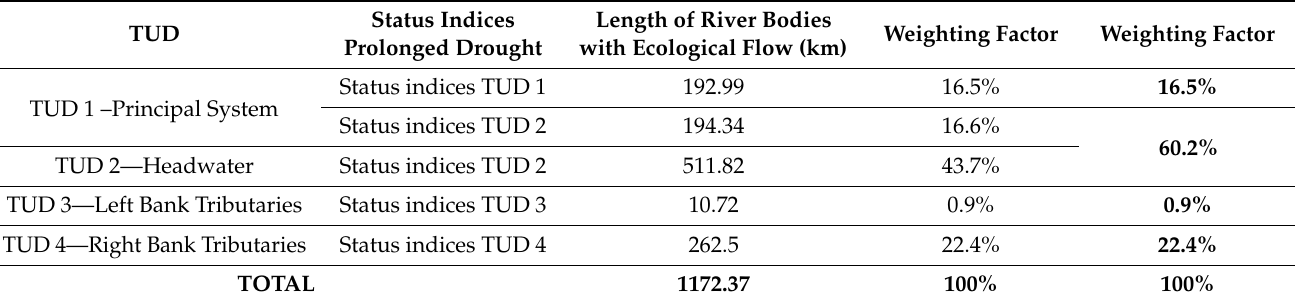
Table 7. Status indices of each TUD. Source: SPD 2018